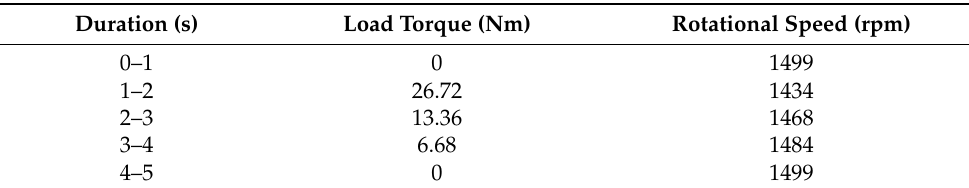
Table 2. Different load conditions of step load torque.